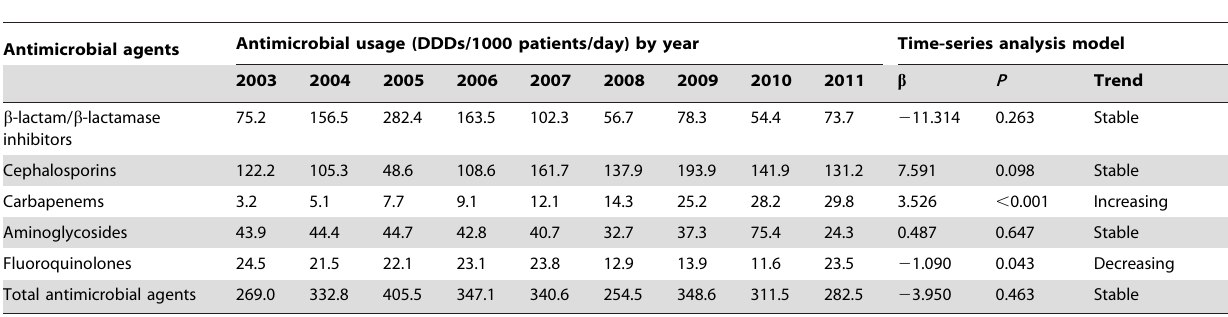
Table 2. Annual usage trends of antimicrobial agents used for the treatment of infections in First Hospital of Jilin University, 2003– 2011.